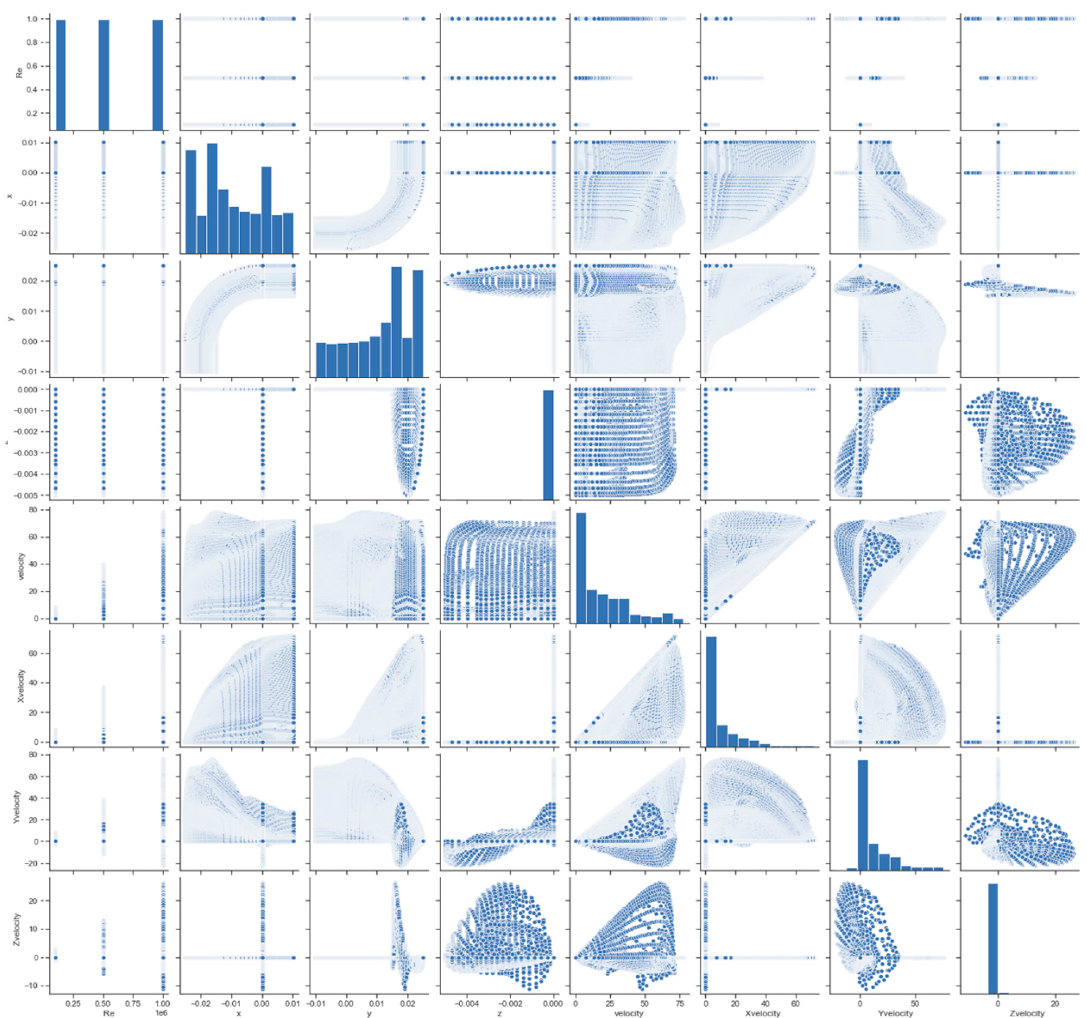
Figure 3. Scatter plot matrix of the feature and the targets.